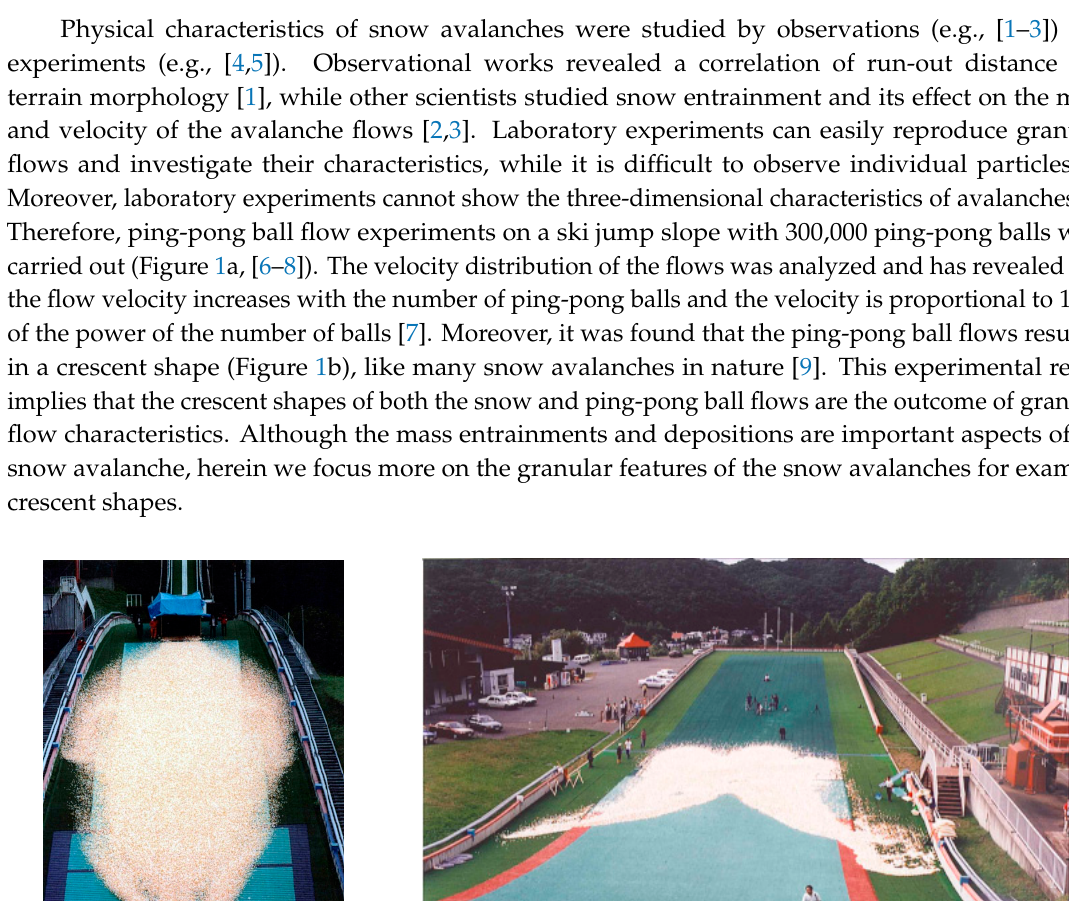
Figure 2. Numerical simulation results of the ping-pong ball experiments. The flow direction is from left to right. Deposit shape predicted by ( a ) the I- dependent model with 𝛿 (cid:2870) = 30° and 𝛿 (cid:3020) = 20°; ( b ) Titan2D with 𝜙 (cid:3036)(cid:3041)(cid:3047) = 30° and 𝜙 (cid:3029)(cid:3032)(cid:3031) = 20°.